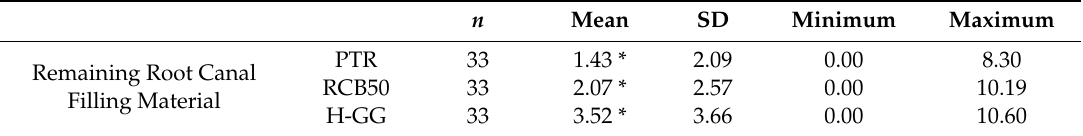
Table 4. Descriptive analysis of the proportion of remaining carrier-based root canal filling material (%) regarding the non-surgical endodontic retreatment study groups. n